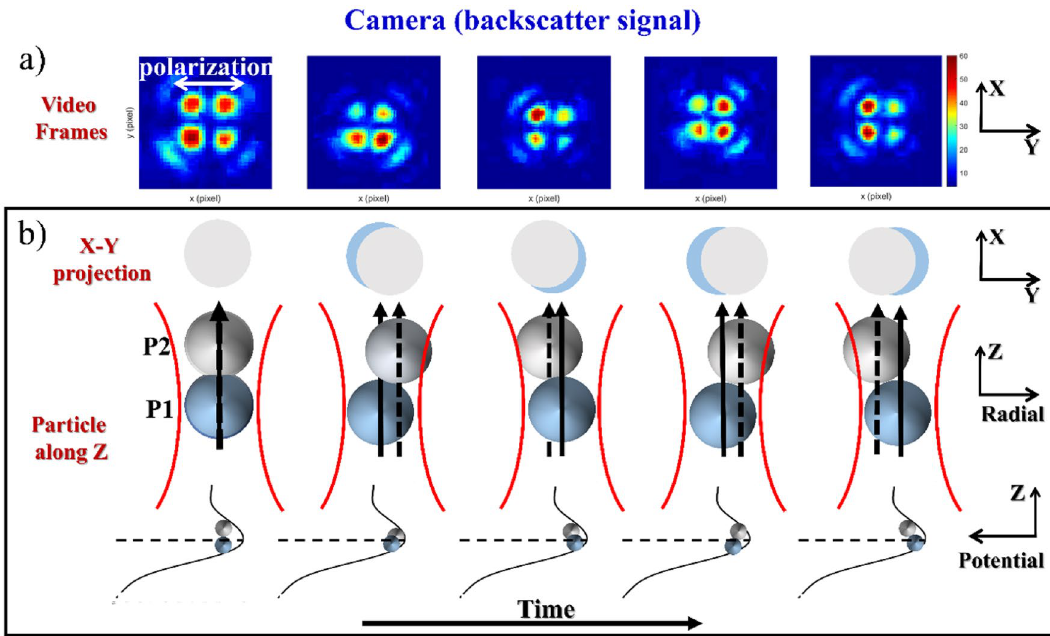
Figure 2. Two-particle backscatter pattern changing over time where the dashed arrow shows lateral deviation from the beam axis (shown as solid arrow); horizontal dotted line represents the focal plane (z = z 0 ) under pulsed excitation. The first row is the scattering pattern captured while two particles are trapped within the focal volume (each images is of 30 pixel × 30 pixel in dimension with each pixel having an area of 3.60 µm × 3.60 µm). The second row represents a proposed model depicting the X–Y projection of trapped particles corresponding to the axial alignment of these particles inside the potential well shown in third and fourth